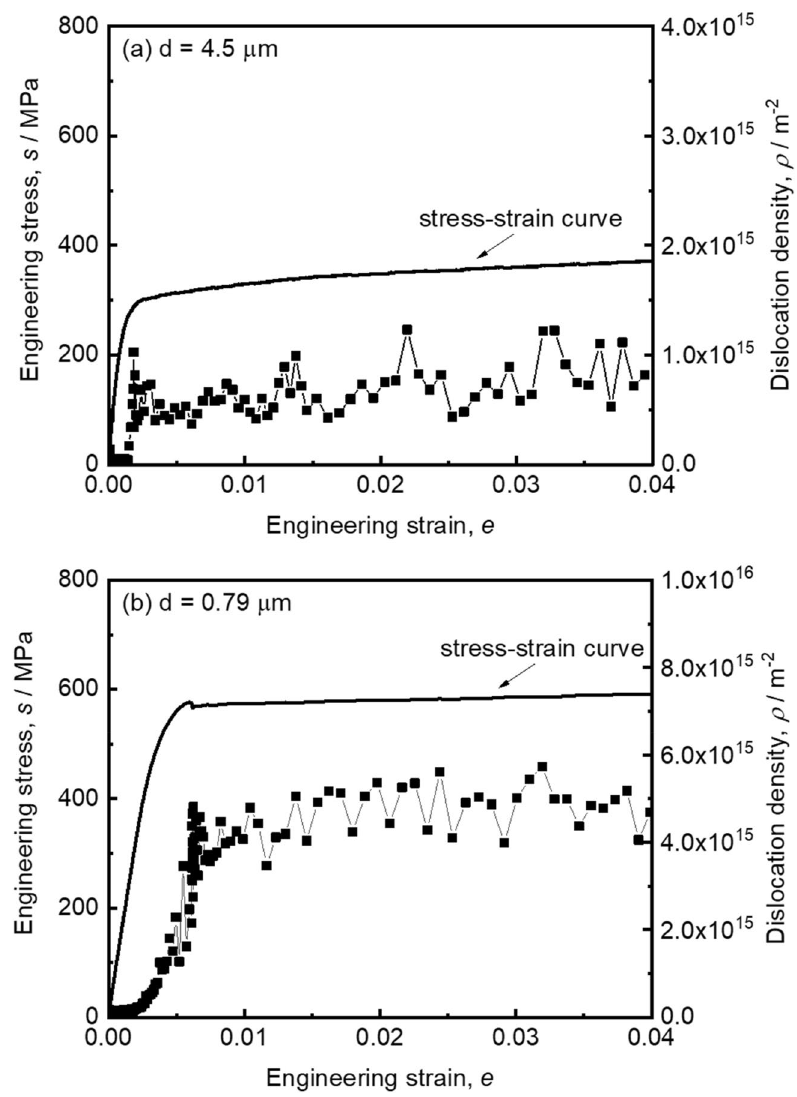
Figure 3. Engineering stress–strain curves and changes in dislocation densities in the small tensile strain region around macroscopic yielding in the specimens with the mean grain sizes of ( a ) 4.5 μm, and ( b ) 0.79 μm. The dislocation densities were evaluated from the results of the in-situ XRD